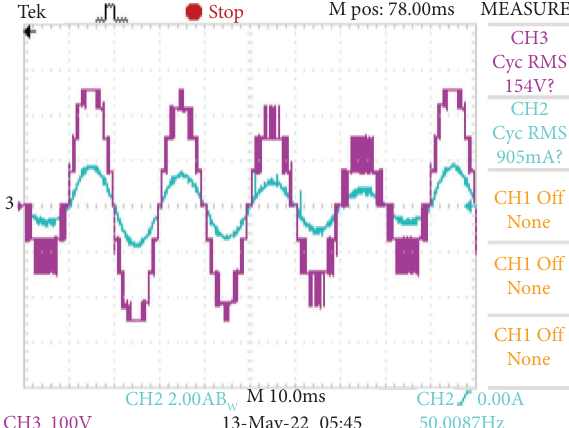
Figure 24: Dynamic variation of M